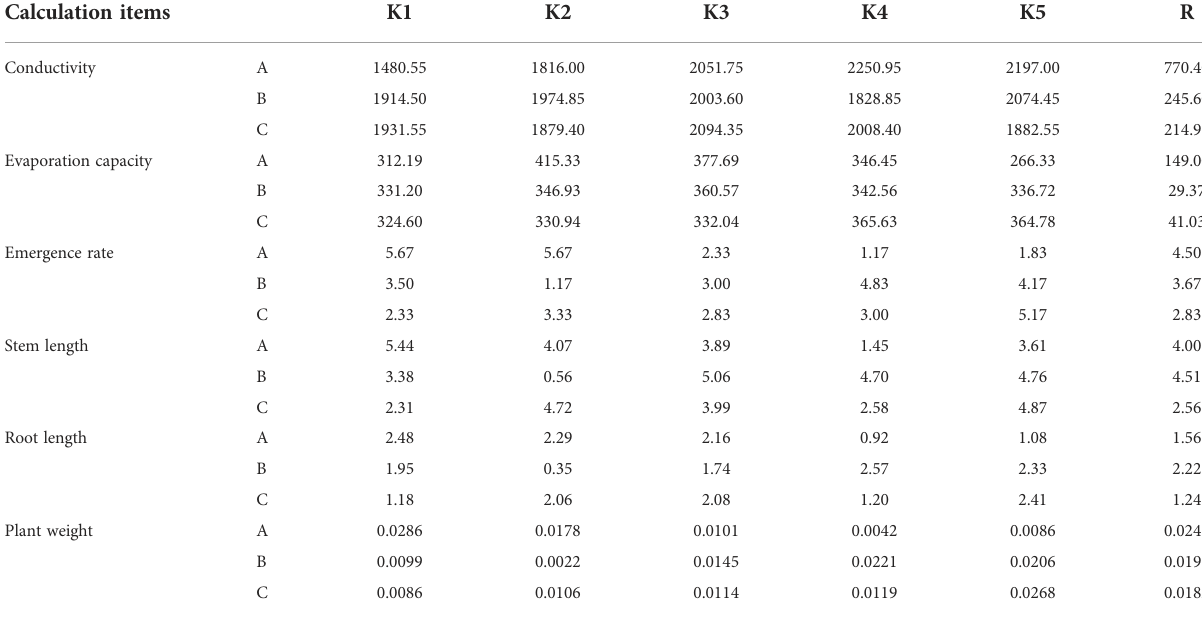
TABLE 8 Experimental range analysis